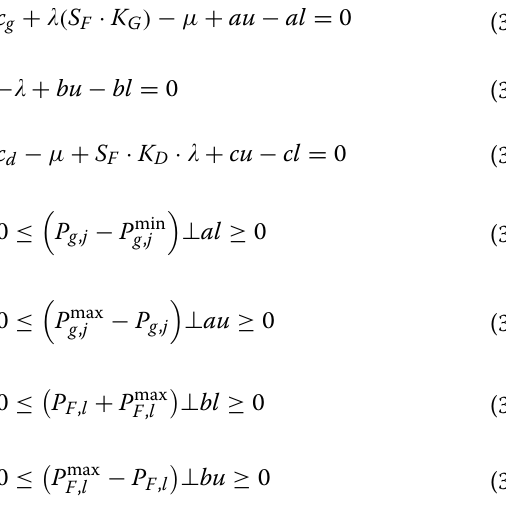
Fig. 4 IEEE 14-bus system